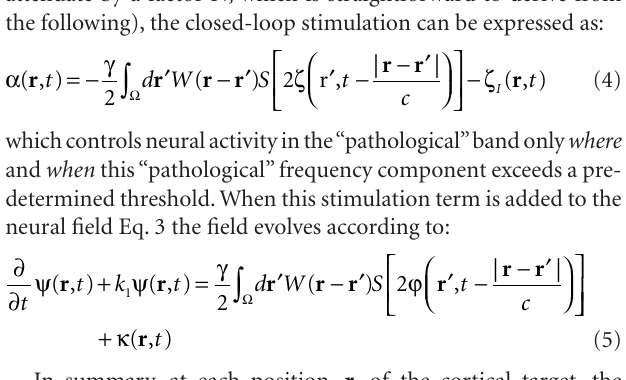
Figure 2 | Localization, frequency analysis and coherence of primary motor cortex (M1) activity with tremor. Magnetoencephalographic (MEG) and electromyographic (EMG) data acquired in a PD patient with right hand tremor. The arrow shows where the MEG signal is recorded. The power